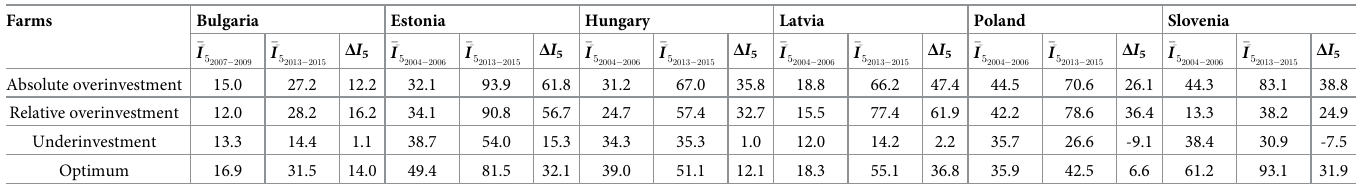
Table 6. Value of fixed assets other than land, calculated per employee (EUR/AWU), in farms grouped by scale of investment in 2007–2009 and 2013–2015 ( I